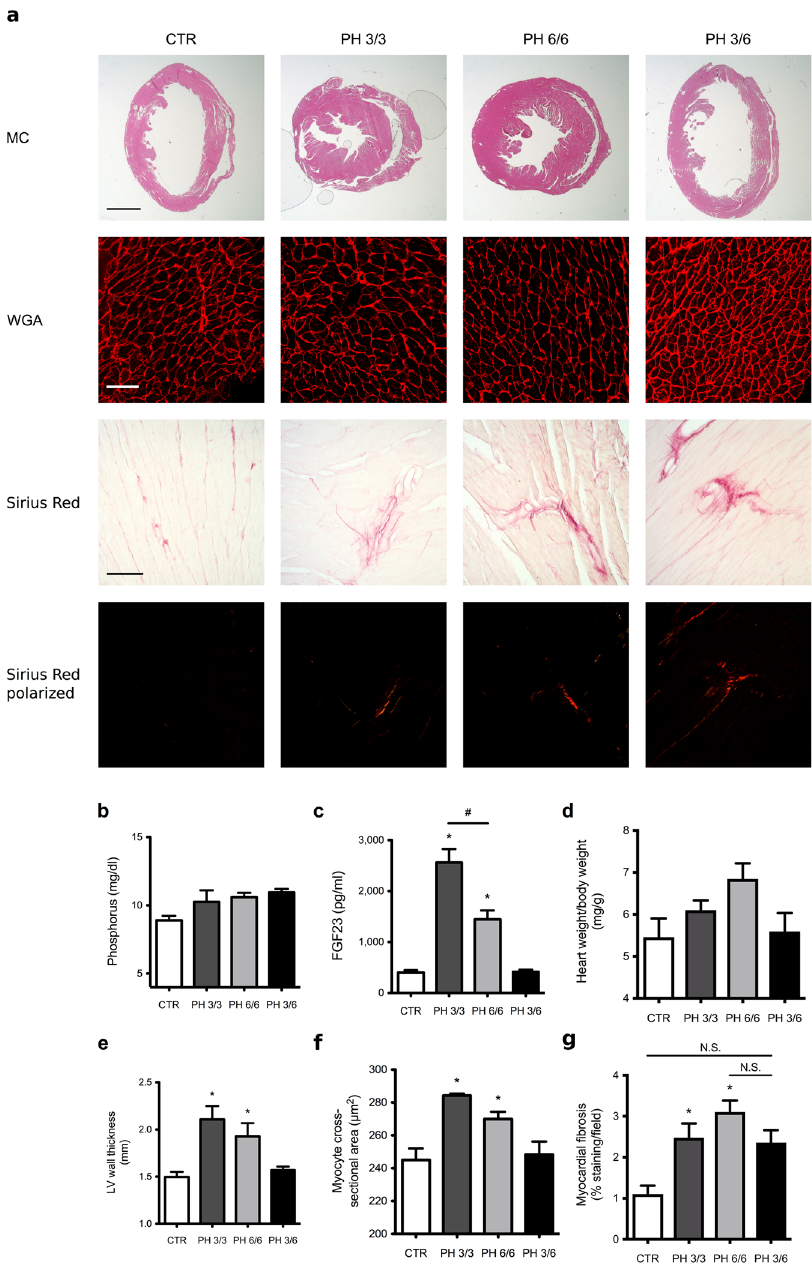
Figure 3. LVH induced by high phosphate diet is reversible in mice. Compared to normal chow (CTR), mice on a high phosphate diet for 3 months (PH 3/3) and 6 months (PH 6/6) develop LVH. Mice on a high phosphate diet for three months followed by a normal chow diet for three months (PH 3/6) do not develop LVH. ( a ) Upper panel: representative gross pathology of mid-chamber (MC) sections of the heart (H&E stain, original magnification x5, scale bar 2 mm). Middle panel: representative WGA-stainings of the LV free wall (original magnification x63, scale bar 50 µ m). Lower two panels: representative Picrosirius Red stainings demonstrating fibrosis in the LV free wall (original magnification x10, scale bar 100 µ m). ( b ) Compared to CTR, mice on a high phosphate diet (PH 3/3, PH 6/6 and PH 3/6) show a trend towards higher serum phosphate levels. ( c ) Serum FGF23 levels are significantly increased in animals fed a high phosphate diet (PH 3/3, PH 6/6) and return to normal levels when mice are transitioned to normal chow for three months (PH 3/6). ( d ) Mice on high phosphate diet exhibit a trend towards increased ratios of heart weight to body weight. ( e ) Average LV wall thickness as measured by seven individual angles at 0, 30, 60, 90, 120, 150, 180 degrees along the LV free wall from the hemi-circle of the short axis. ( f ) Cross-sectional area of 25 myocytes per field of 4 fields along the LV free wall. ( g ) Quantification of myocardial fibrosis (8 fields of view around the LV). All values are mean ± SEM (n = 4–9 per group; * p < 0.05 compared with CTR, # p < 0.01 between